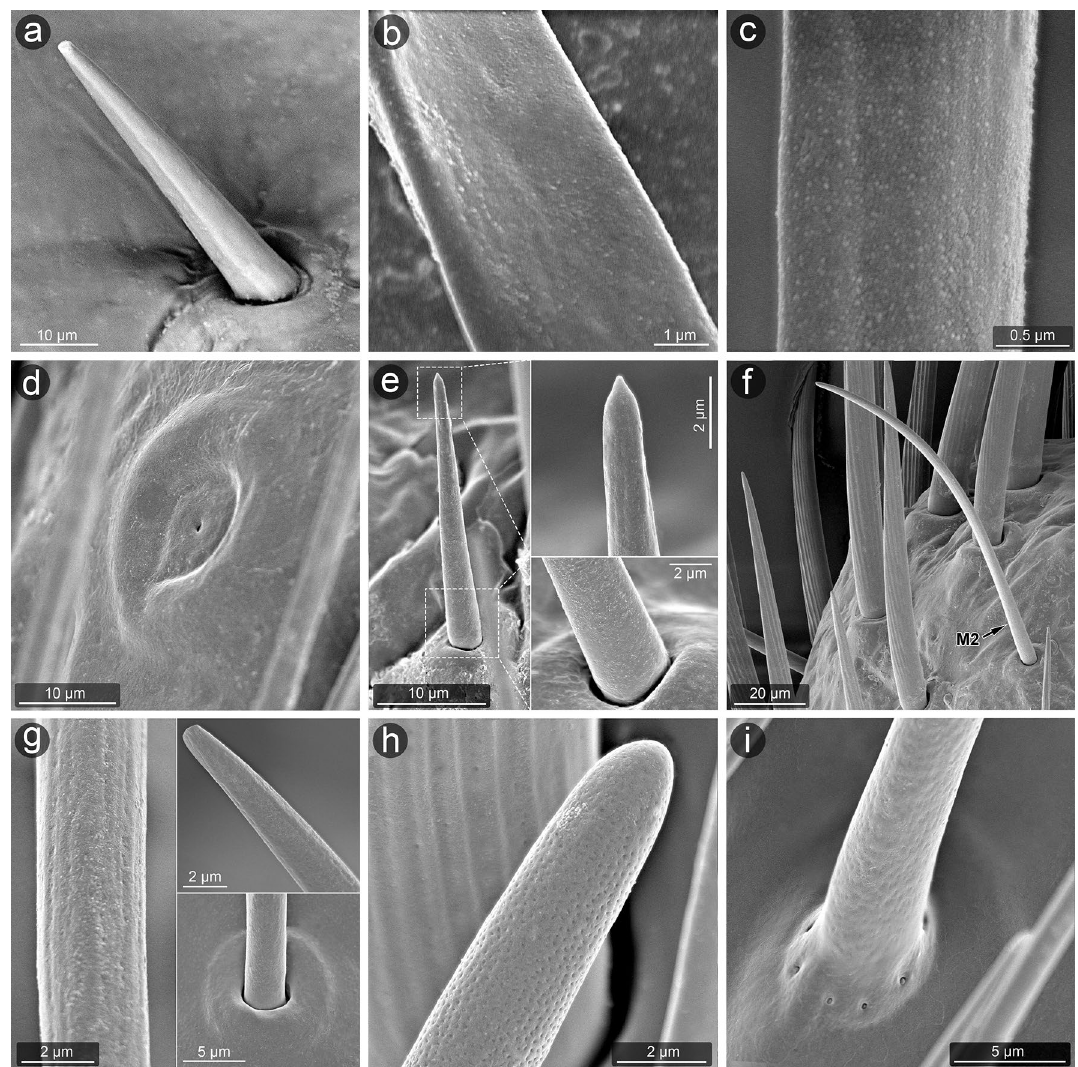
Figure 5. Micromorphology of selected types of sensilla ( L. occidentalis ) analysed in SEM. Type A1 ( a ); A2 ( b ); mic. ( c ); A4 ( d ); M3 ( e ); M2 ( f , g ); M4 ( h ); M5 ( i ). Abbreviations are given in the